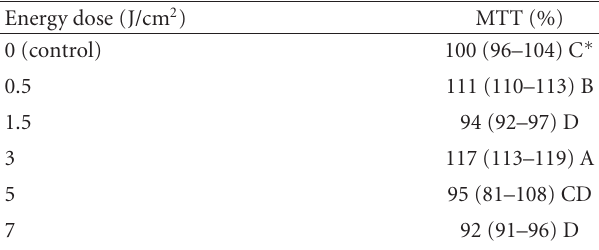
Table 1: Succinate dehydrogenase enzyme (SDH) production by human gingival fibroblasts detected by the MTT assay according to the energy dose used in the low-level laser therapy.